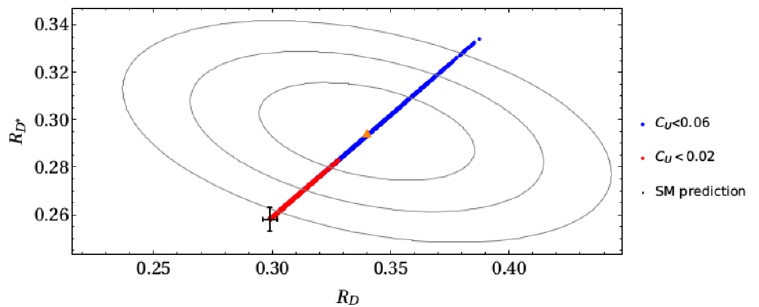
Figure 6 . Scatter plot of C ( n ) function of the degree of compositeness of the quark doublet of the third generation: (cid:15) q .